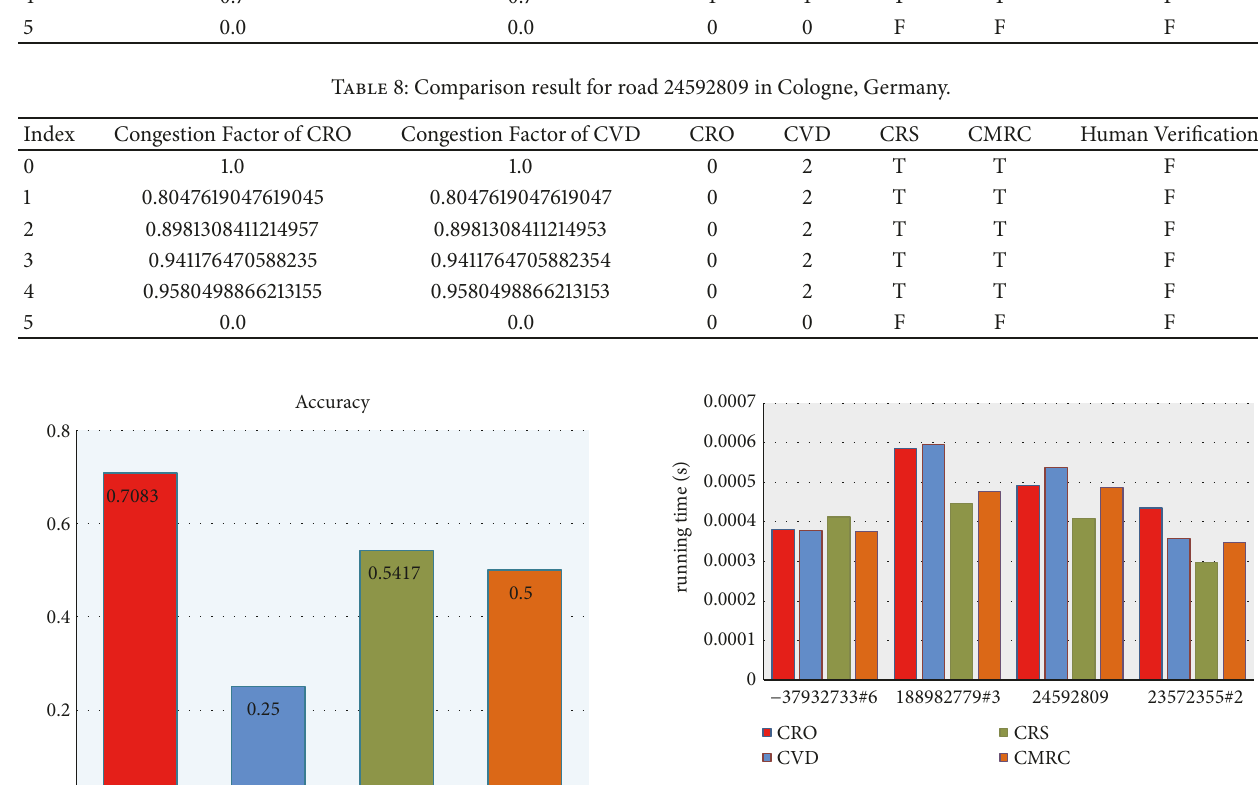
Figure 5: Comparison of running time for different congestion evaluation algorithms. From the efficiency detection module in the framework, the algorithm running time comparison diagram is shown in Figure 5. It can be seen from the diagram that two algorithms based on macroscopic traffic flow characteristics, namely, CVD algorithm and CRO algorithm, consume about the same time. The CRS algorithm and the CMRC algorithm consume the same time and are lower than the first two algorithms. But in fact, the overall time consumption of all these four algorithms is lower than that of data